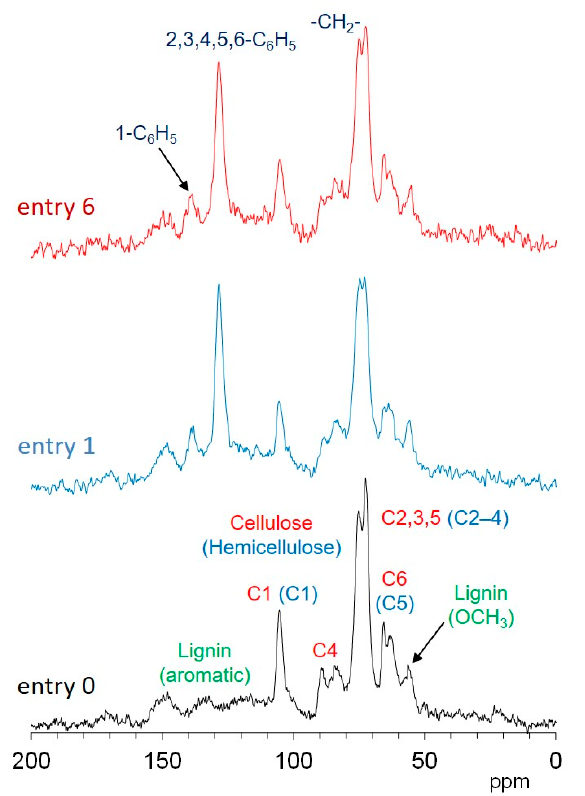
Figure 5. 13 C CP-MAS NMR spectra of degreased wood (entry 0, black) and benzylated woods (entry 1, blue; and entry 6, red).